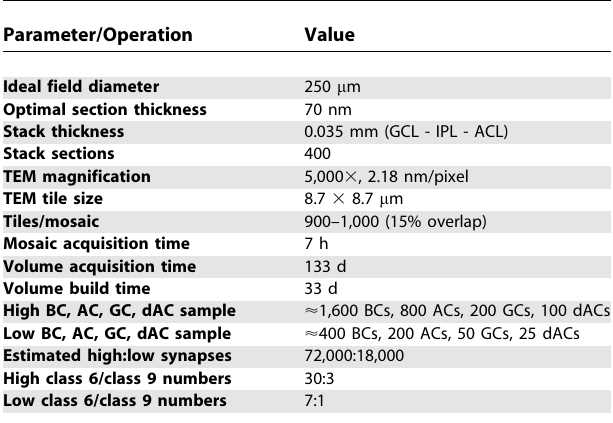
Table 3. Parameters and Timeline for CN Mapping a